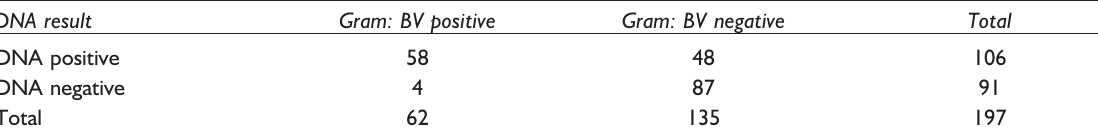
Table 1 Sensitivity of DNA hybridisation compared with Gram stain DNA result Gram: BV positive Gram: BV negative Total DNA positive 58 48 106 DNA negative 4